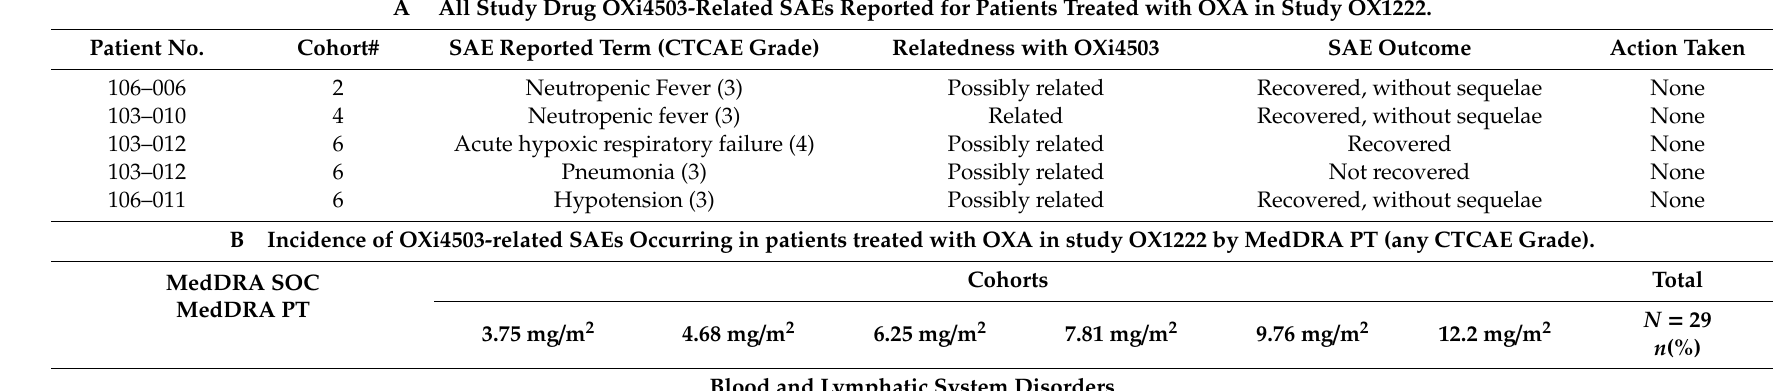
Table 3. OXi4503-related serious adverse events